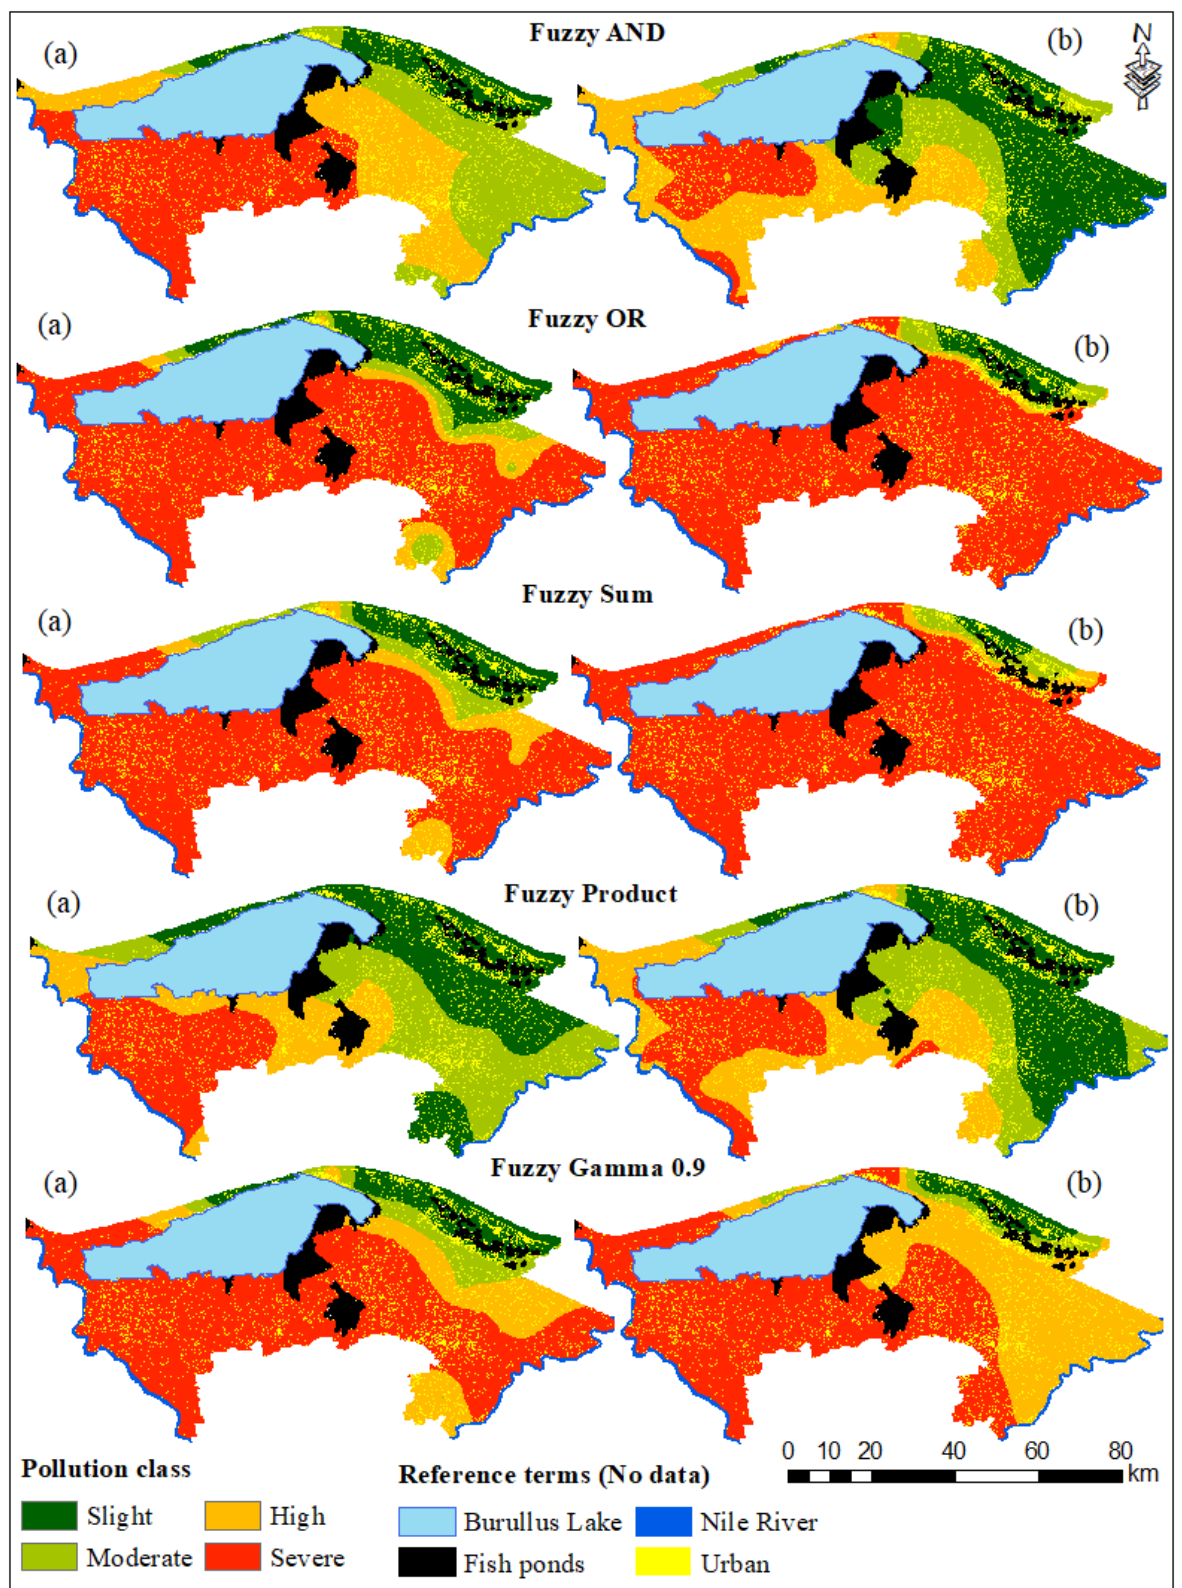
Figure 4. Overlay maps (based on weighted mean value of soil profiles) for soil pollution using linear ( a ) and non-linear ( b ) normalization methods.